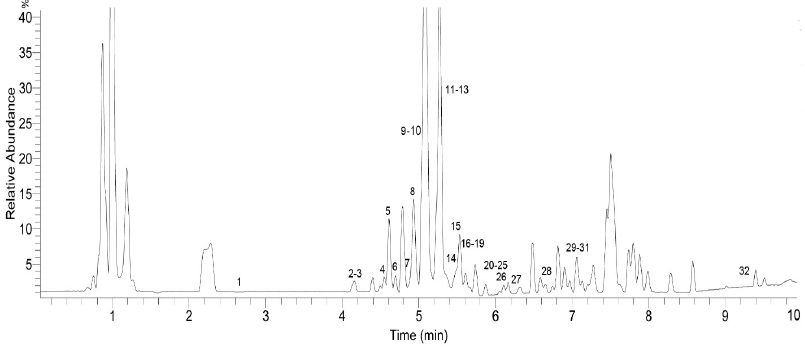
Figure 3. Base peak chromatogram (BPC) of the ethyl acetate fraction (EA) of F. dibotrys (negative ion mode).